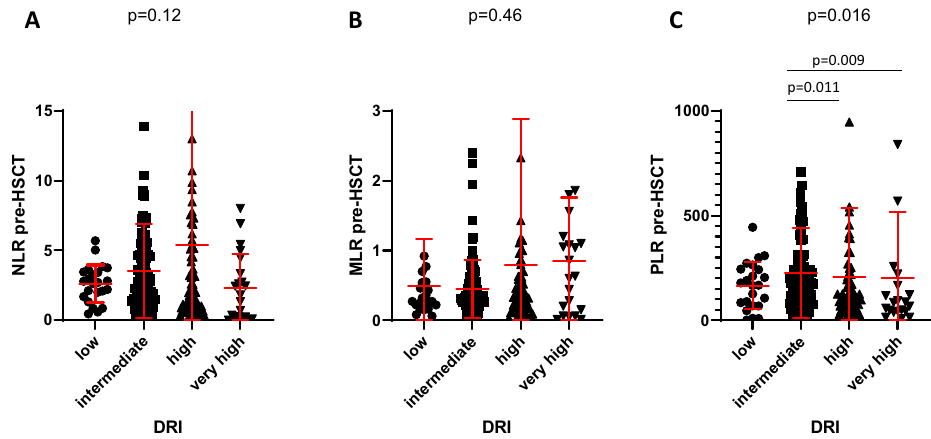
Figure 2. Association between NLR, MLR, PLR and Disease Risk Index (DRI). Regarding DRI no significant differences could be observed for NLR ( p = 0.12, A ) and MLR ( p = 0.46, B ). For PLR patients in the intermediate risk group showed significant higher PLR compared to patients in the high risk group ( p = 0.009) and very high risk group ( p = 0.011, C